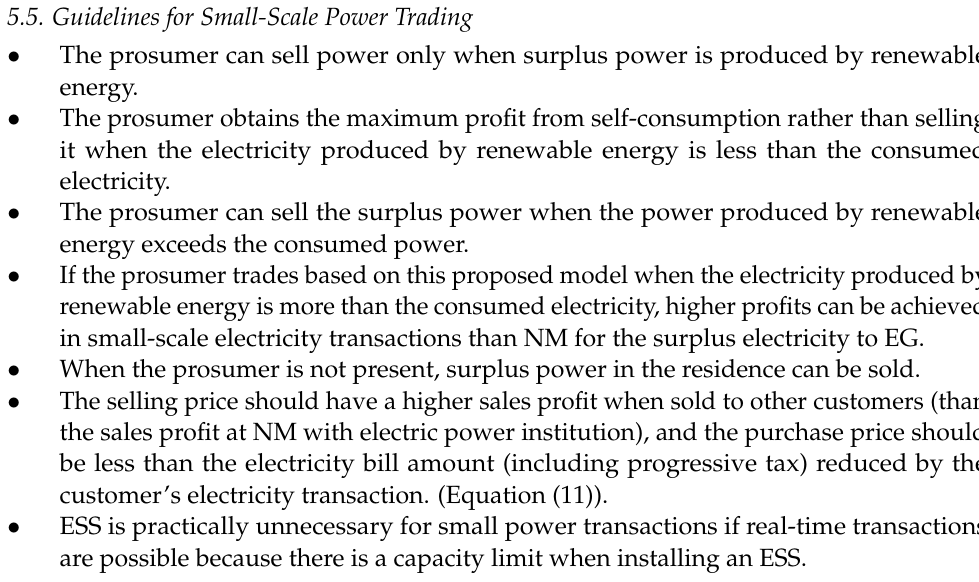
Figure 18. Change in γ and ROI according to the change in ε